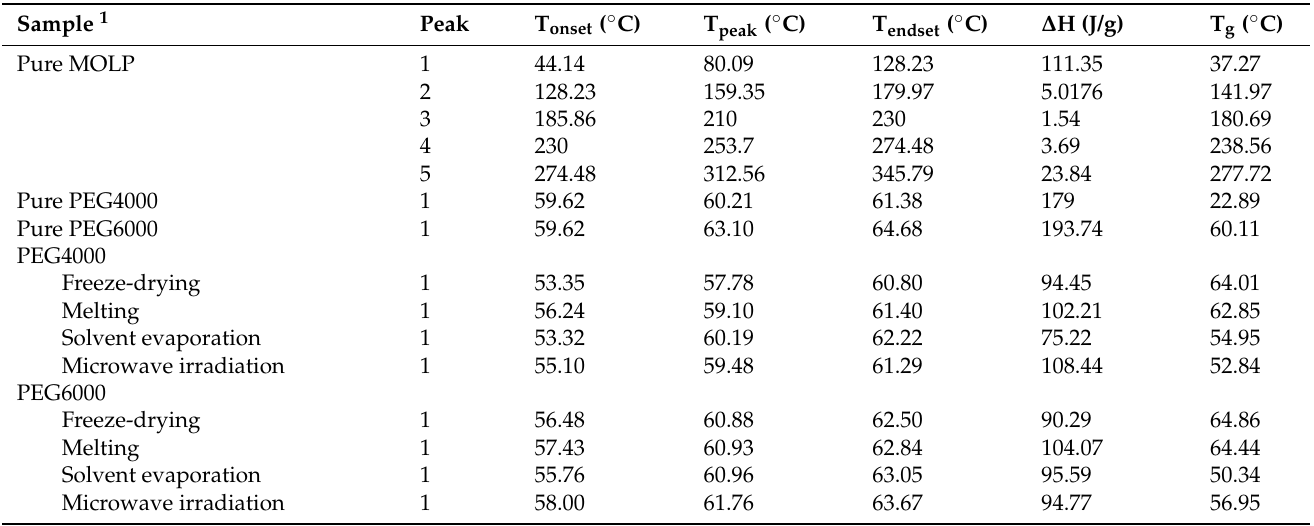
Figure 5. DSC thermograms of solid-dispersed MOLP through freeze-drying with PEG6000 ( a ), PEG4000 ( b , c ) and microwave ( d ) using PEG6000; and ( e ) Solvent evaporation, ( f ) Freeze-drying, ( g ) Melting and ( h ) microwave prepared using PEG4000. Table 1. Thermal properties of MOLP and solid dispersions at the heating rate of 10 ◦ C min − 1